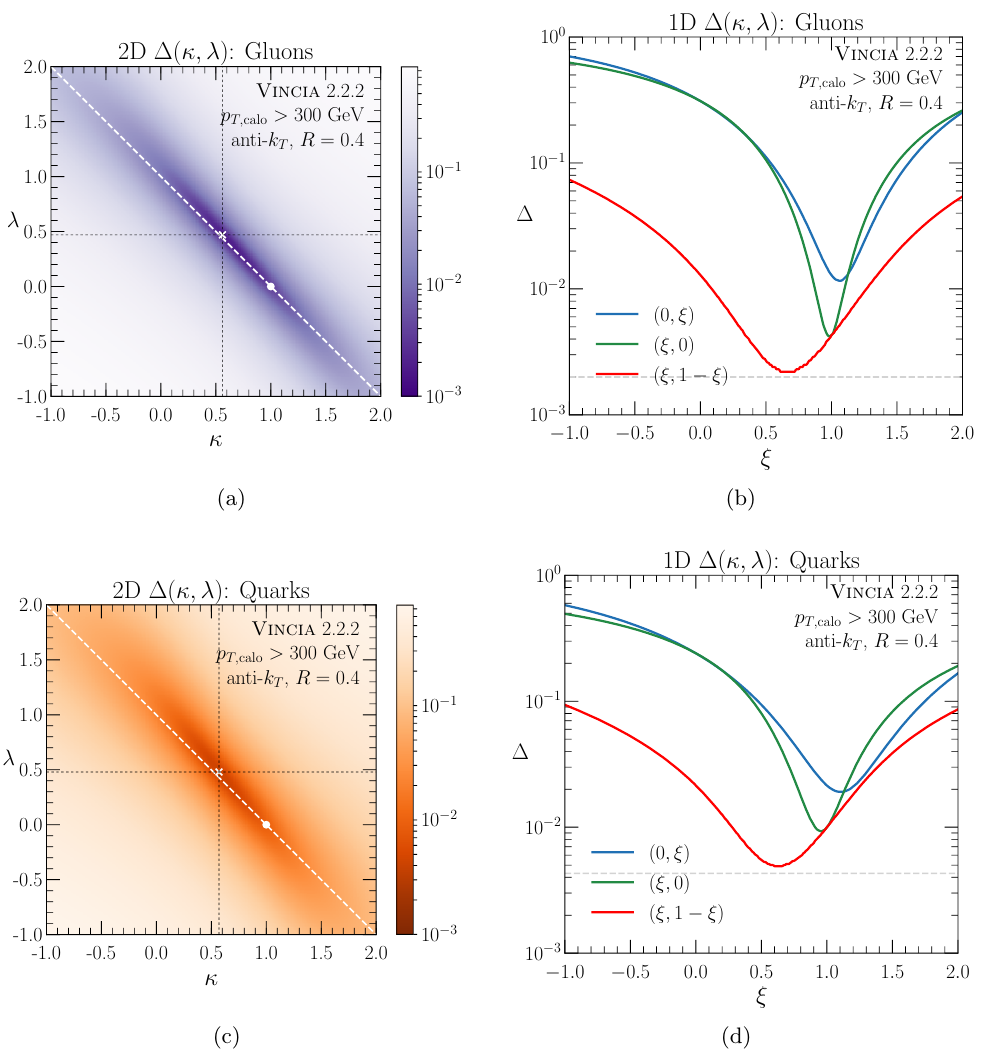
Figure 18 . Distribution of (cid:1)( (cid:20); (cid:21) ) for the processes pp be compared to (cid:12)gure 5. The full two-dimensional distributions are on the left, and slices of these distributions are shown on the